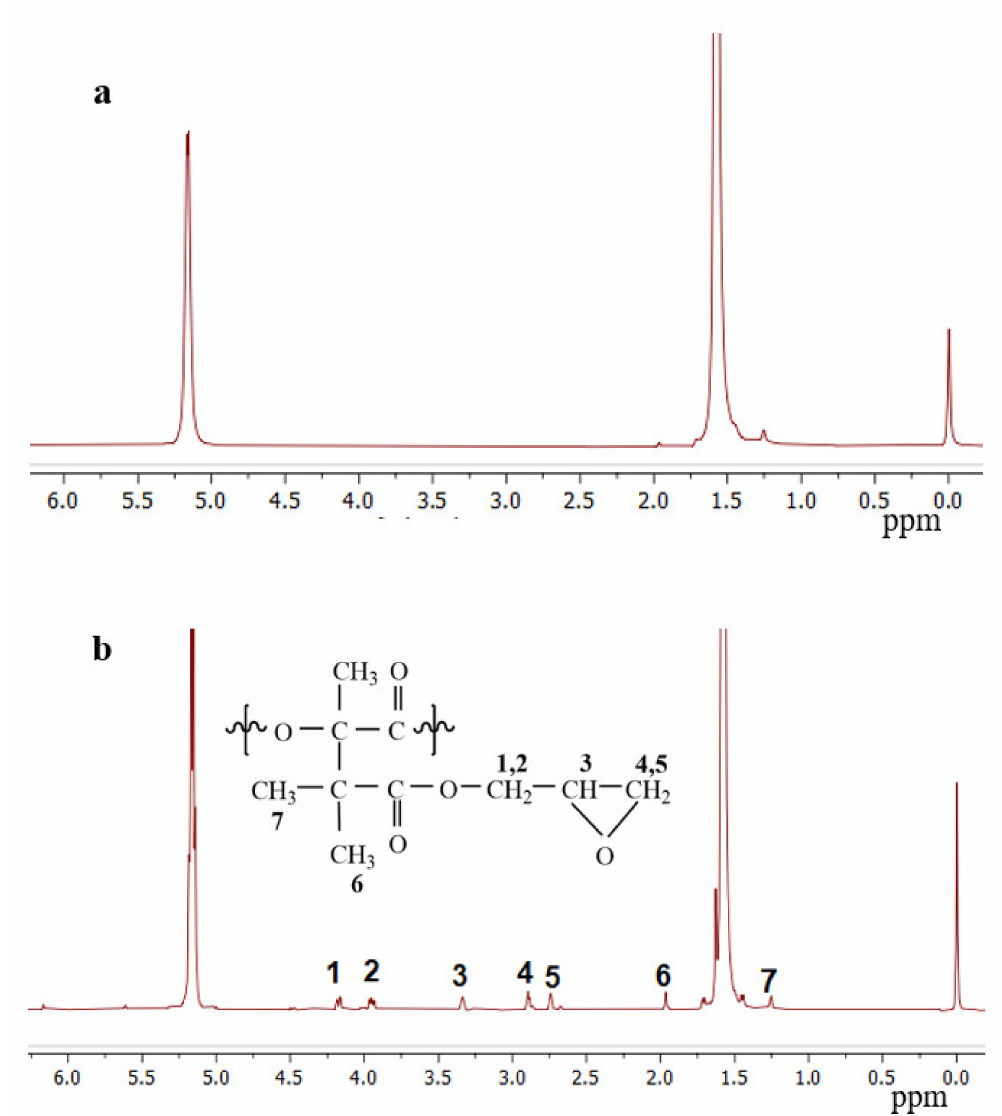
Figure 2. 1 H-NMR spectra of PLA ( a ) and PLA-g-GMA graft copolymer ( b